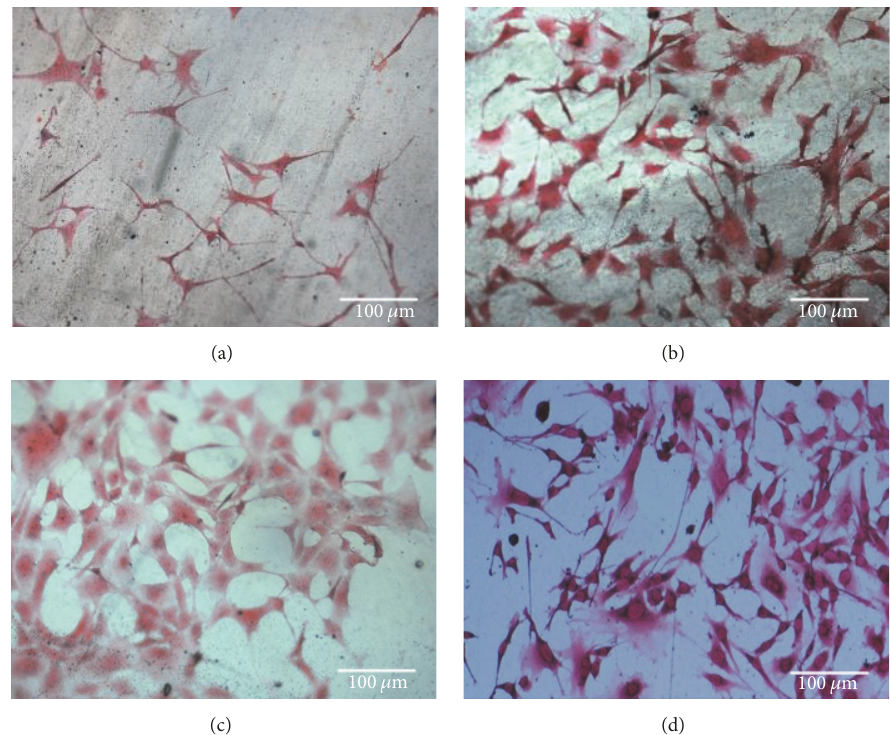
Figure 7: NIH-3T3 cells culture on PLA films at (a) 24 hours, (b) 48 hours, and (c) 72 hours and (d) control culture plate (400x magnification; bar: 100 𝜇 m).